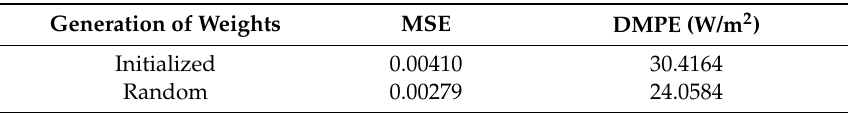
Table 6. Choice of registration of weights for periodic